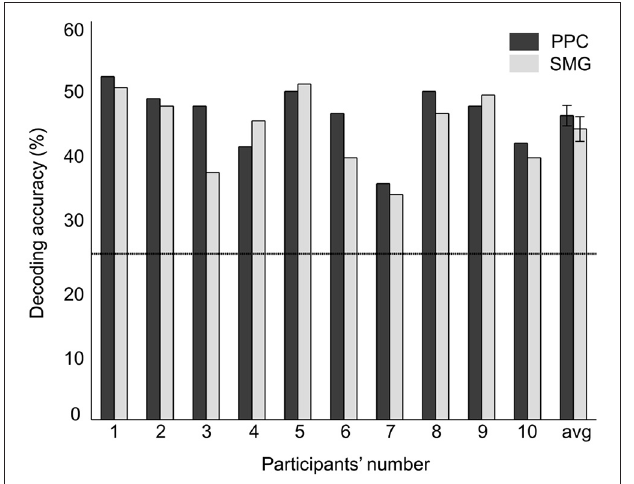
FIGURE 3 | Decoding accuracies of each significant cluster from searchlight MVPA . The rightmost value indicates the average decoding accuracy across all the participants. Error bars indicate standard errors and a chance level is marked by the dashed line (25%).